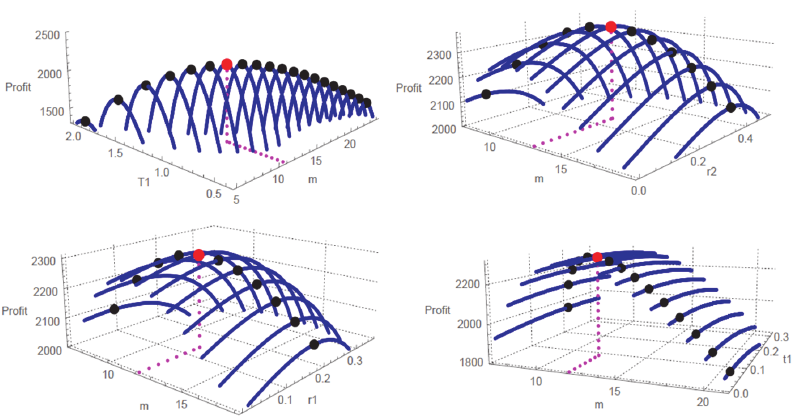
Fig. 2 Concavity of the function (cid:1852)